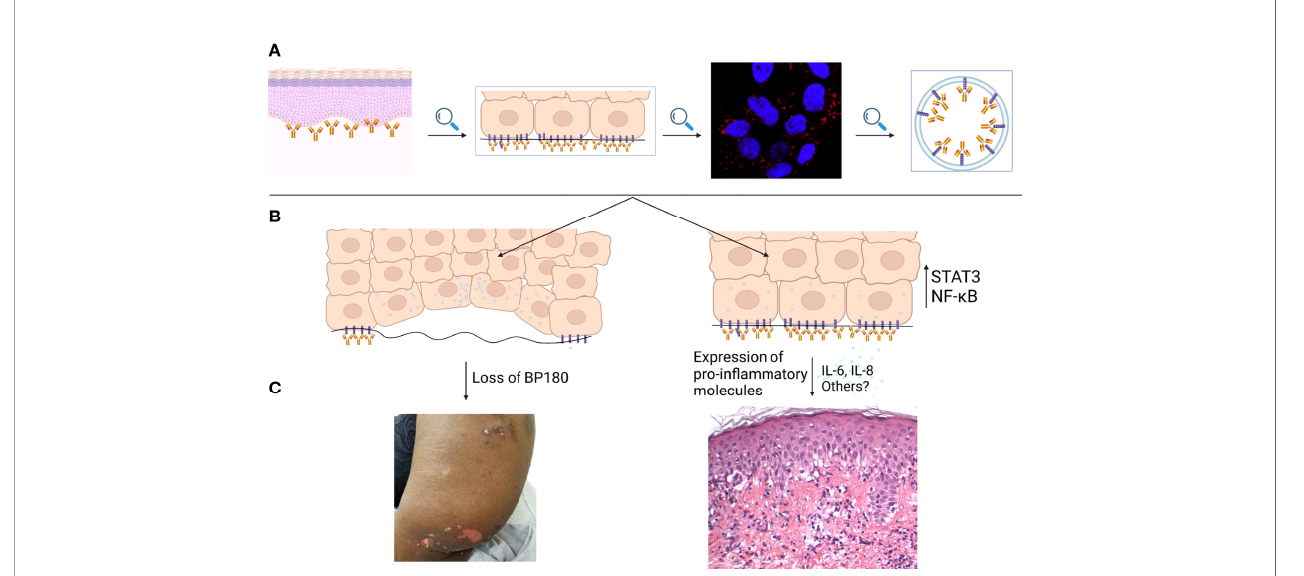
FIGURE 1 | Keratinocyte mediated, complement-independent pathways in bullous pemphigoid. (A) IgG autoantibodies targeting BP180 bind to the epidermal basement membrane. IgG-BP180 complexes undergo macropinocytosis as shown by immunostain for EEA-1. (B) Internalized IgG-BP180 complexes lead to both loss of cellular BP180 and increased expression of proin fl ammatory mediators such as IL-6 and IL-8, resulting in both (C) pauci-in fl ammatory and pro-in fl ammatory complement-independent